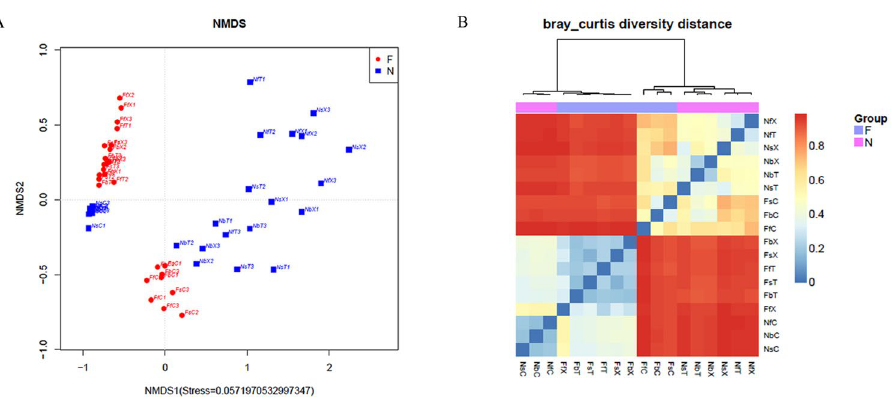
Figure 5. β -diversity analysis of different treatments. ( A ) Cluster analysis of different treatments. ( B ) Bray– Curtis distance analysis of different